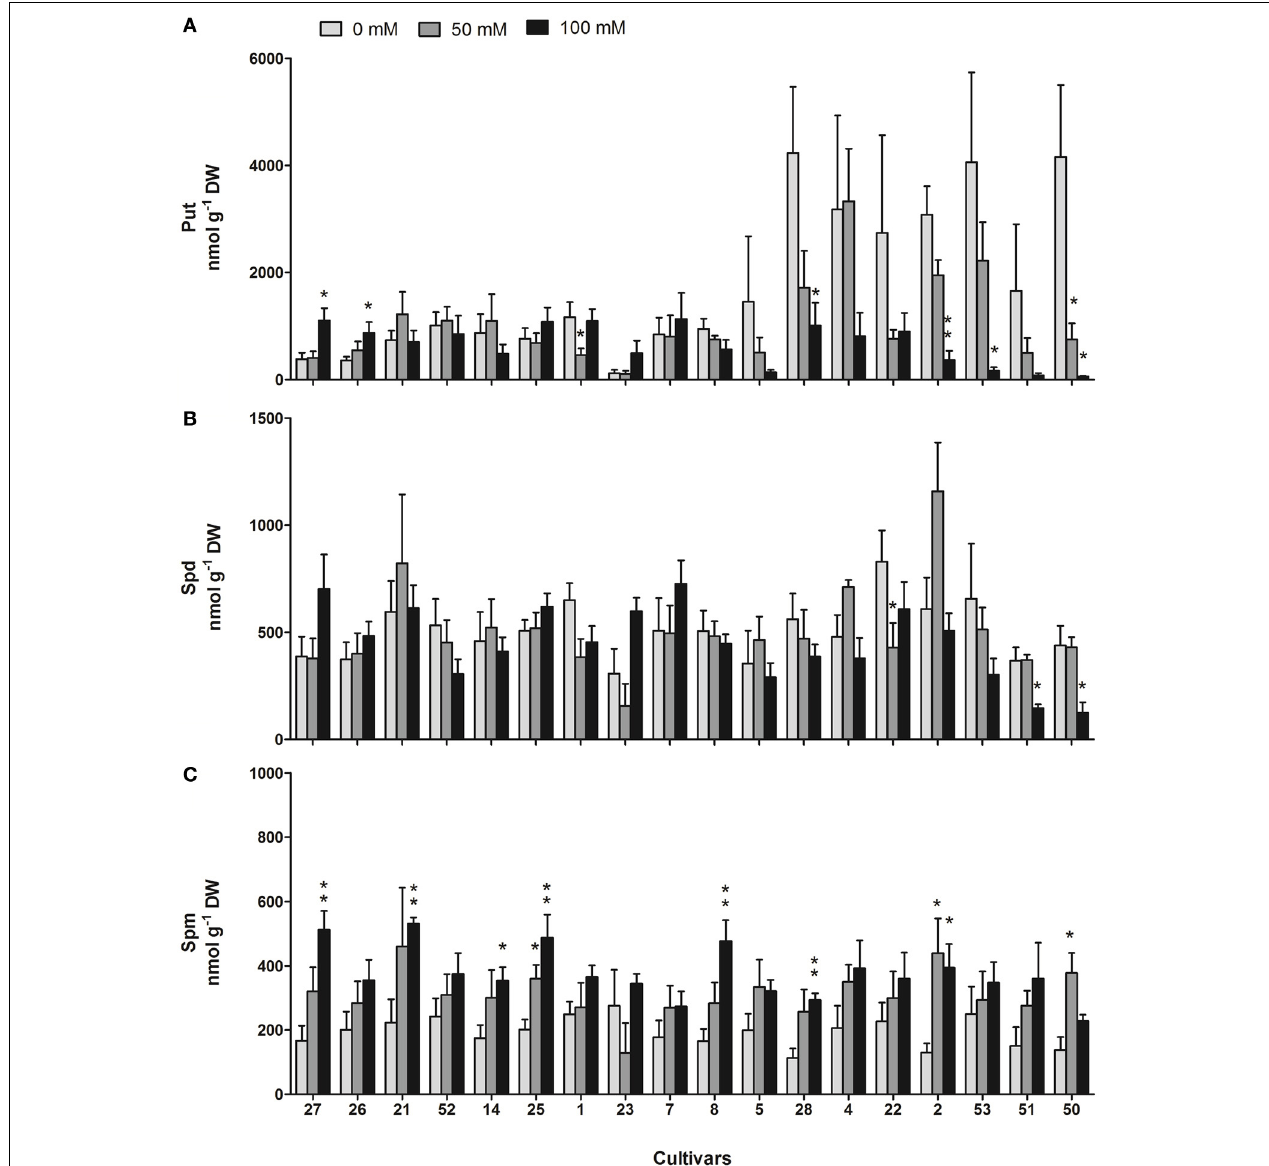
FIGURE 4 | Polyamine content under control and salt stress (50 and 100mM NaCl) conditions. The panels show Put (A) , Spd (B) , and Spm (C) content inleaves of18ricecultivars.Eachvaluerepresents themean( ± s.e.m.)